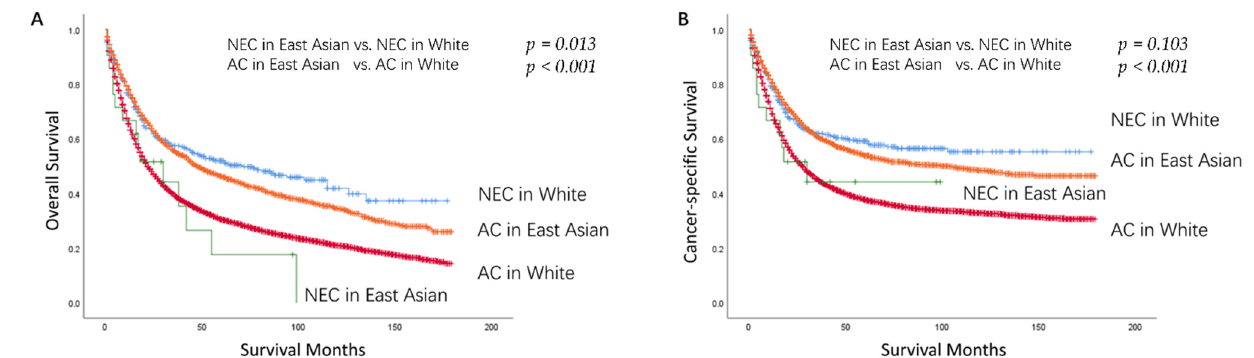
Figure 3. Kaplan–Meier Survival Curves for GNEC and GAC in different races in the Unmatched Data (( A ): OS; ( B ): CSS). NEC: Neuroendocrine Carcinoma; AC: Adenocarcinoma; OS: Overall Survival; CSS: Cancer-specific